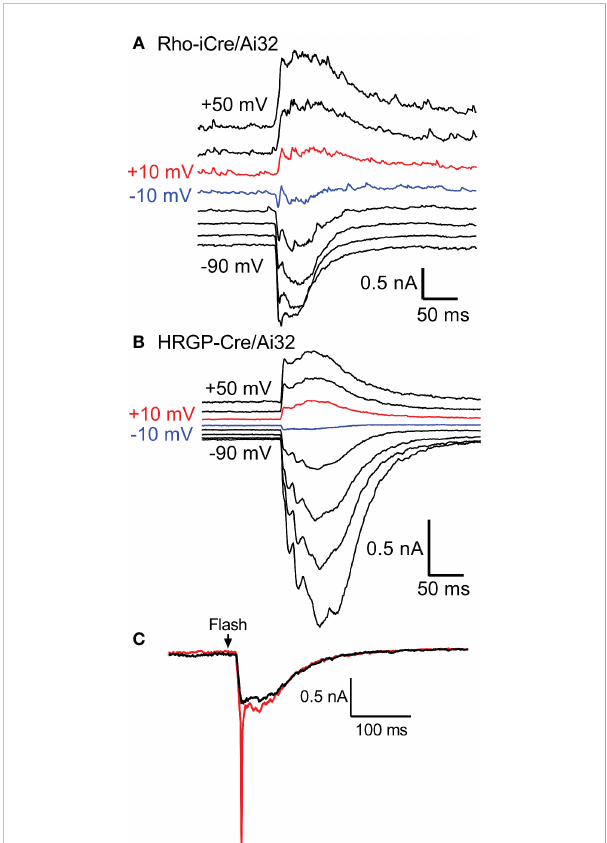
FIGURE 3 Responses of OFF a RGCs at different membrane potentials (20 mV steps from -90 to +50 mV) evoked by optogenetic stimulation of rods (A) and cones (B) . The recording in A was from an OFF transient cell in a Rho-iCre/Ai32 retina and the recording in B was from an OFF sustained cell in HRGP-Cre/Ai32 retina. In both, responses reversed between -10 mV (blue trace) and +10 mV (red trace). (C) At the beginning of a recording, optogenetic stimulation often evoked a rapid inward current arising from voltage-dependent Na + currents (red trace). Na + currents disappeared during the fi rst few minutes as the Na + channel blocker QX314 (5 m M) diffused into the cell through the patch pipette (black trace). This example was from an OFF transient cell in an HRGP-Cre/Ai32 retina. Experiments in this fi gure were conducted in the presence of strychnine (1 m M) and gabazine (10 m